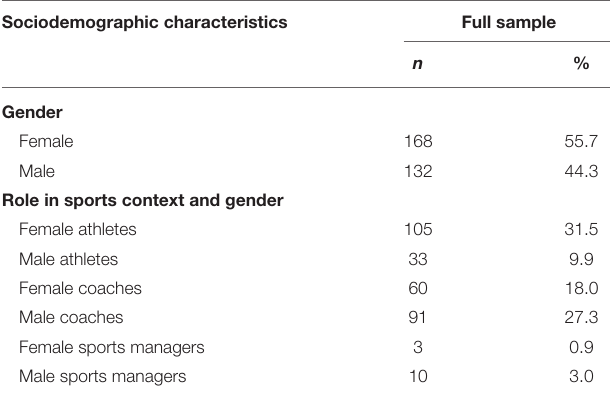
TABLE 1 | Sociodemographic characteristics of